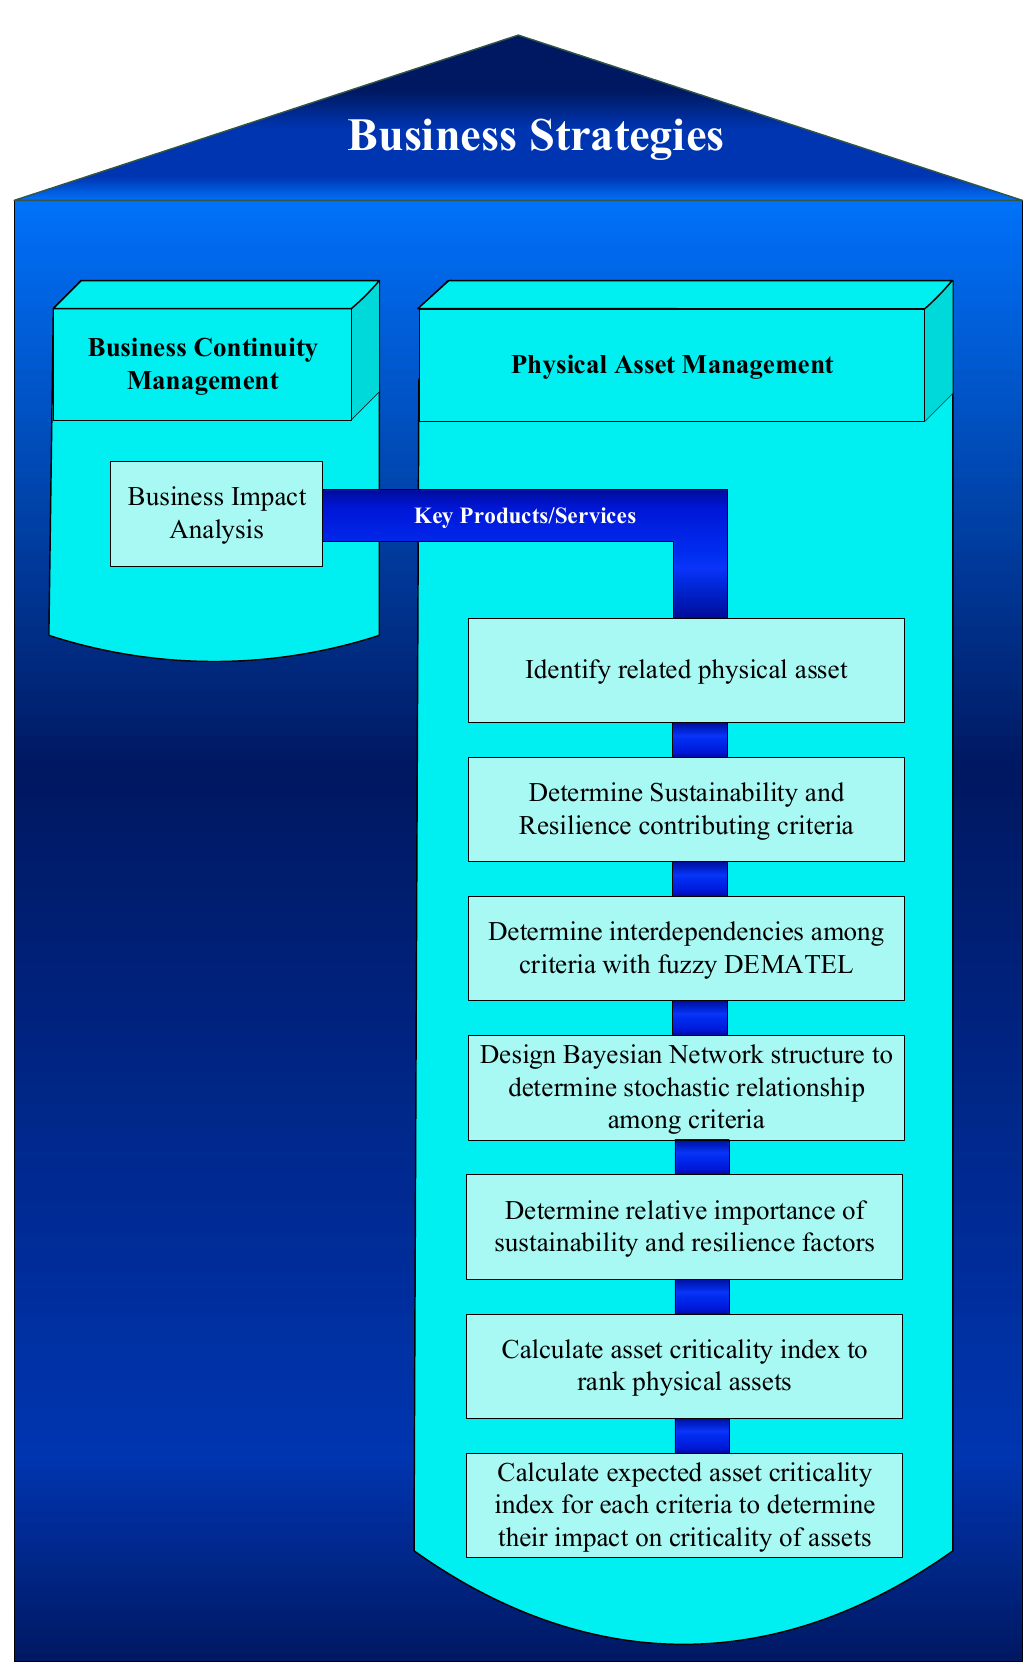
Figure 1. Proposed framework for the BIA-based physical asset criticality analysis.